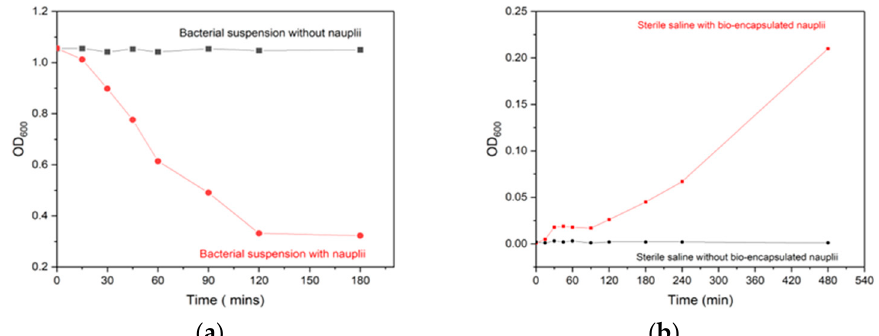
Figure 2. ( a ). Optimization of time of maximum uptake of heat-killed A. hydrophila bacterin (10 7 CFU mL − 1 ) in Artemia nauplii. ( b ) The retention time of heat-killed A. hydrophila bacterin (10 7 CFU mL − 1 ) in Artemia nauplii was analyzed for up to 4 h.